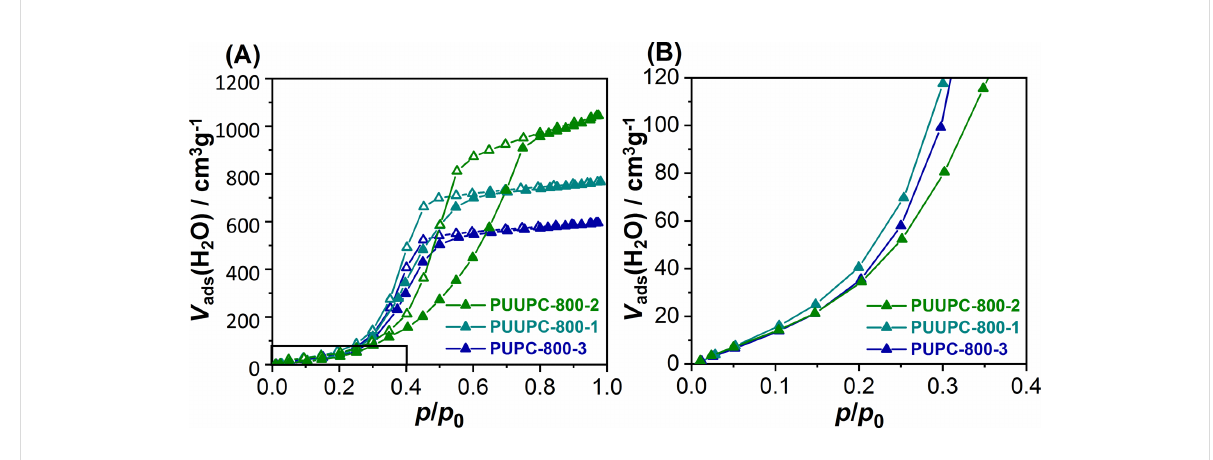
Figure 3: (A) Water vapor sorption isotherms (adsorption/desorption = filled symbols/empty symbols) measured at 25 °C and (B) magnification of the lower relative pressure range of the samples: PUUPC-800-1 (cyan), PUUPC-800-2 (green) and PUPC-800-3 (blue).